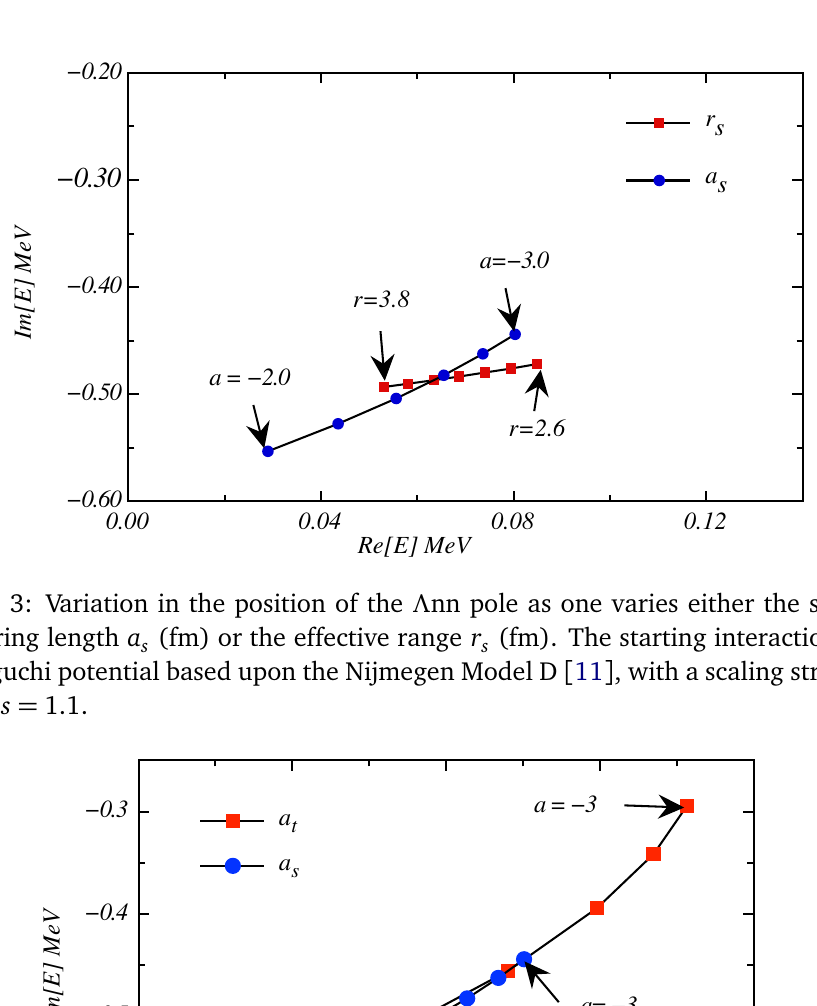
(fm). The starting in- t